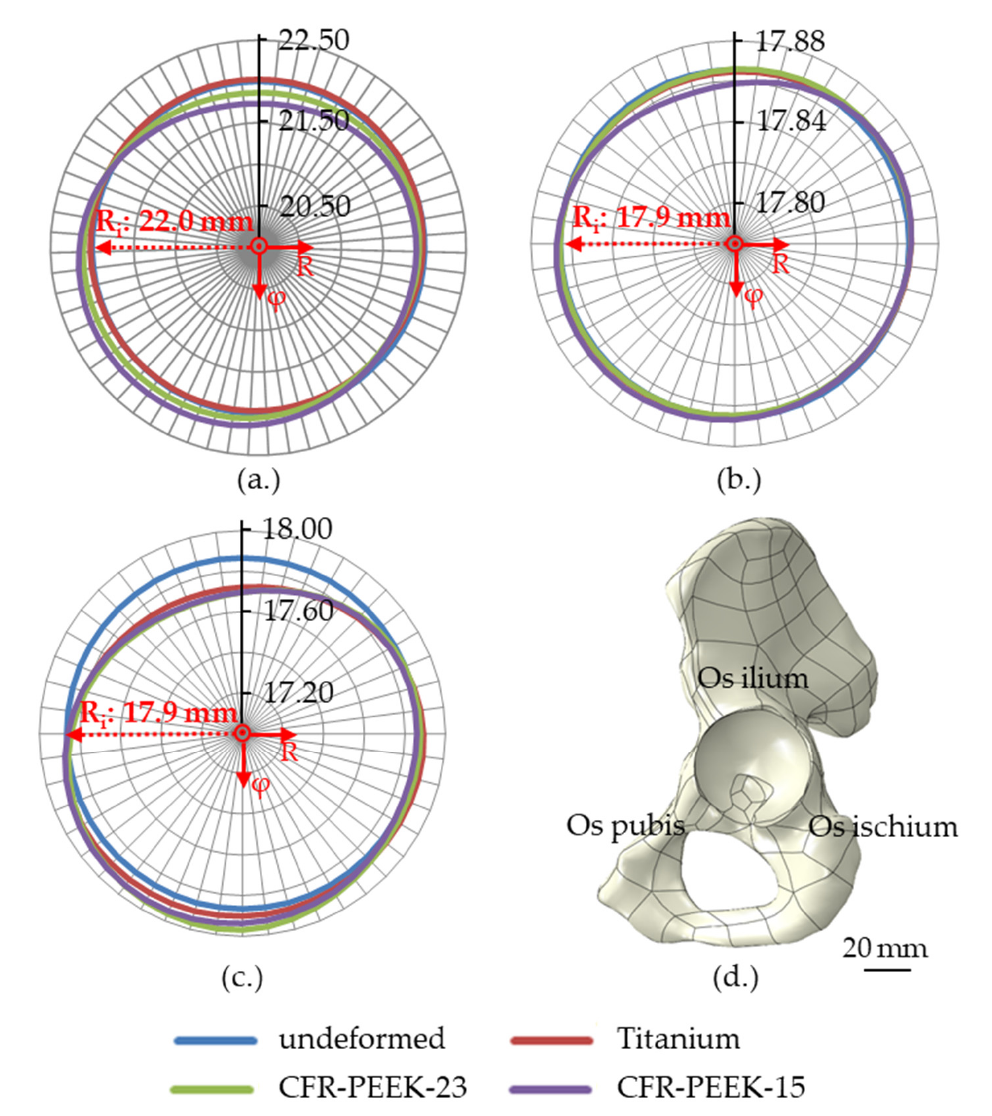
Figure 3. Exaggerated radial deformation (mm) at the inner rim of the shell ( a ) and liners made of ATZ ceramic ( b ) and UHMWPE ( c ) dependent on the chosen shell material and the orientation of the hemi-pelvis ( d ). The deformations are depicted in a polar coordinate system and in relation to the initial radii (R i ).